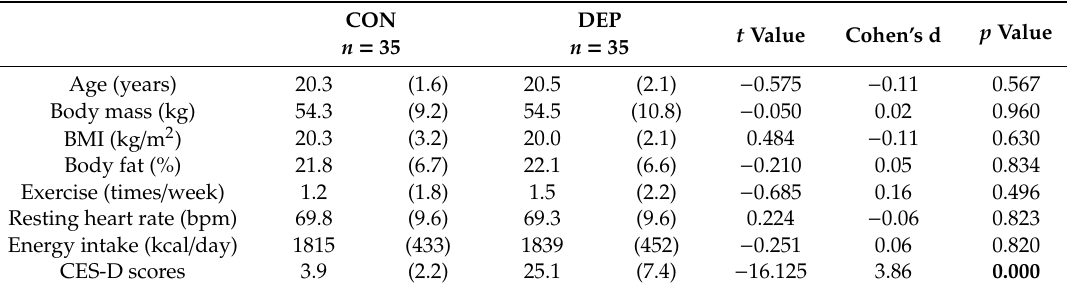
Table 1. Descriptive characteristics of